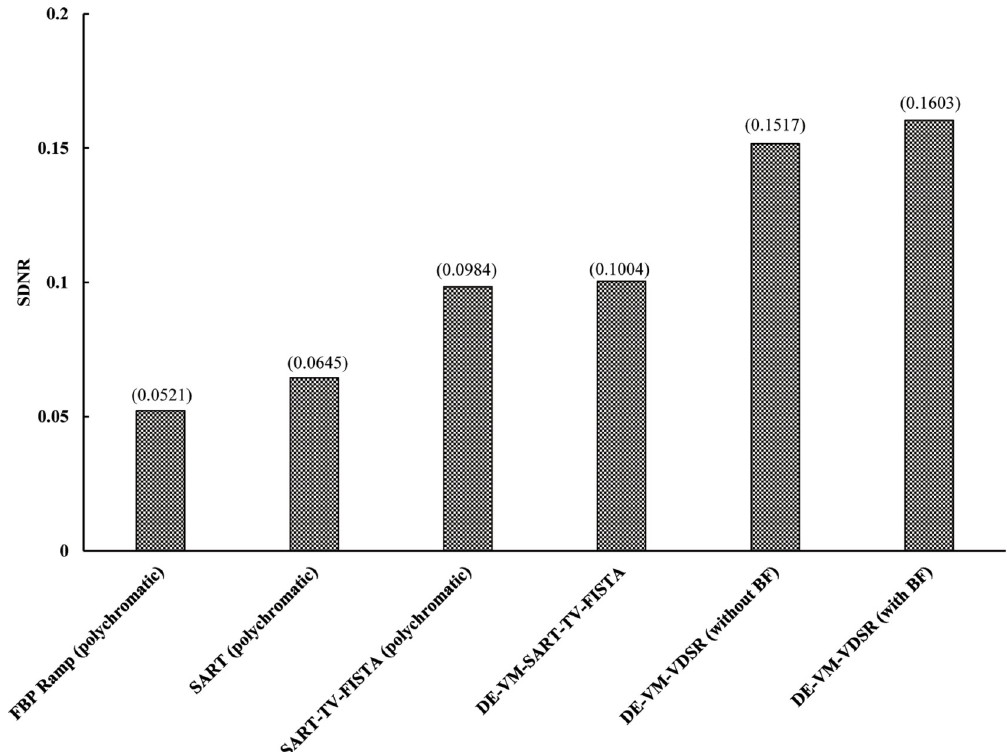
Fig 10. Plots of the SDNR versus each algorithm from the in-focus plane. Comparisons of the signal-difference-to-noise ratio (SDNR) of in-focus plane images obtained via the dual-energy (DE) virtual monochromatic (VM) with the very-deep super-resolution (VDSR) reconstruction algorithm (DE–VM–VDSR) with and without BF and the conventional reconstruction